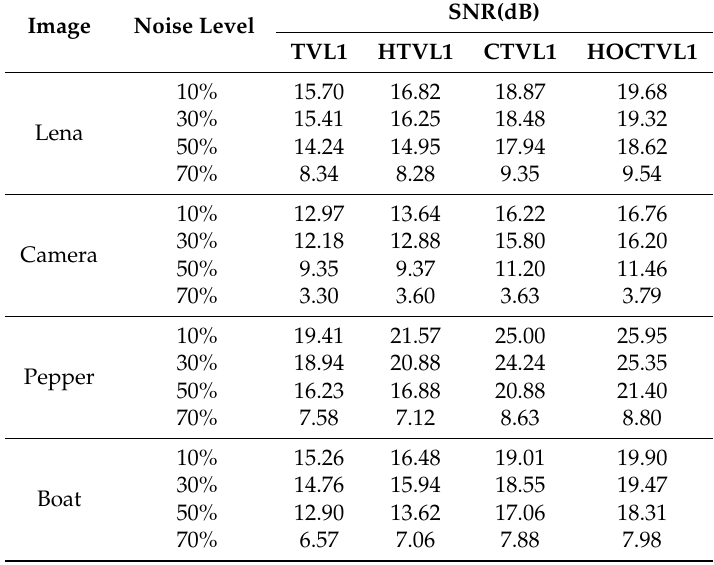
Table 2. SNR of four different models for test images corrupted by Gaussian blur and random-valued noise.